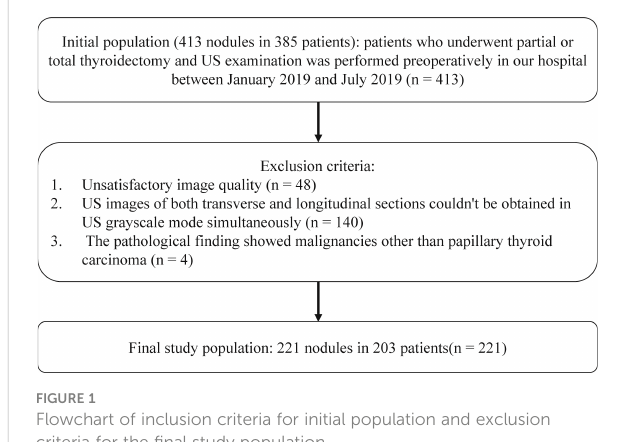
FIGURE 1 Flowchart of inclusion criteria for initial population and exclusion criteria for the fi nal study